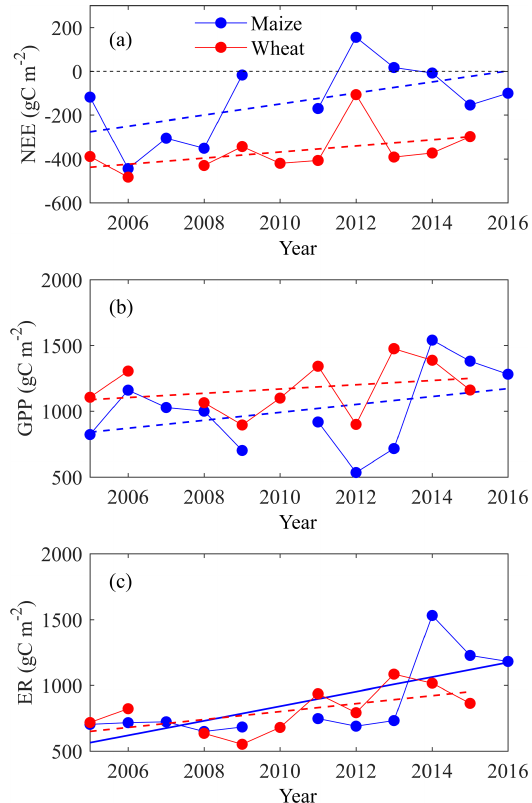
Figure 7. The temporal trend of annual (a) net ecosystem exchange (NEE), (b) gross primary productivity (GPP) and (c) ecosystem res- piration (ER) for both wheat and maize from 2005 to 2016. Note that though most gaps of carbon fluxes were filled, the wheat of 2007 was excluded as it had a large gap accounting for 26% of an- nual records that we were unable to fill. Maize was not planted in the growing season of 2010. Note that the solid line shows where the temporal trend passes F test at p < 0 . 05 significance level, while the dashed line shows where the temporal trend does not pass the F test at p < 0 . 05